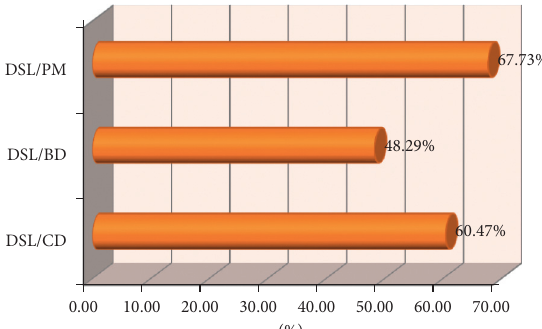
Figure 8: Moisture content of the briquettes with different binders.